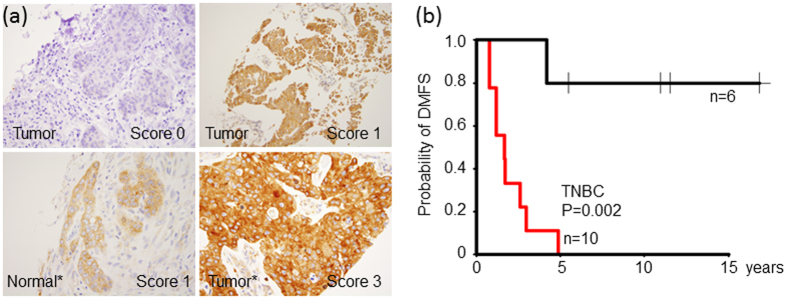
FXR1 overexpression was associated with poor DMFS in TNBC patients.(a) Representative immunohistochemical staining of FXR1 protein expression in sections of formalin-fixed paraffin-embedded breast tumor and adjacent normal* tissues. (b) Kaplan–Meier plot of DMFS of 16 TNBC patients stratified by median FXR1 protein expression. The log-rank P value is shown.